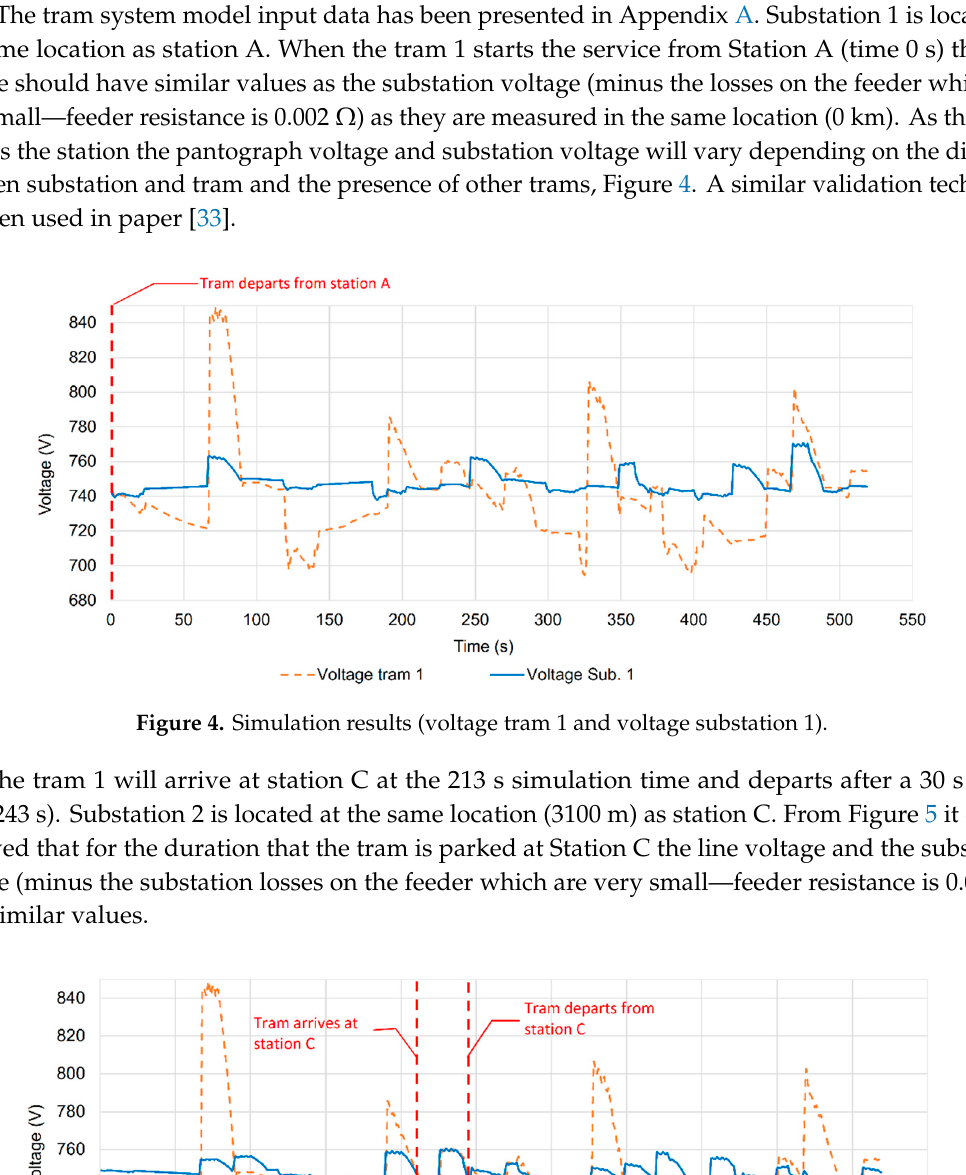
Figure 3. Flowchart of the WESD with SC control.